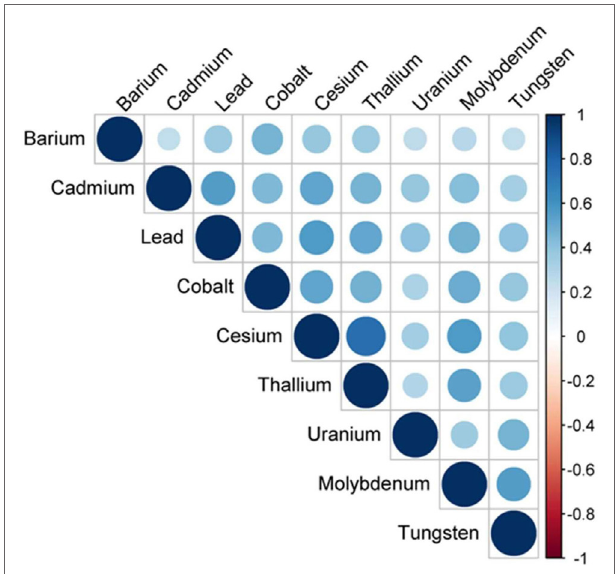
FigUre 3 | Correlation structure of nine urinary metals—National Health and Nutrition Examination Survey 1999–2010. Circle size and color intensity were in proportion to the correlation coefficients. The legend in the right side of correlation structure indicated the correlation coefficients and their corresponding colors. The nine urinary metals were ordered by hierarchical